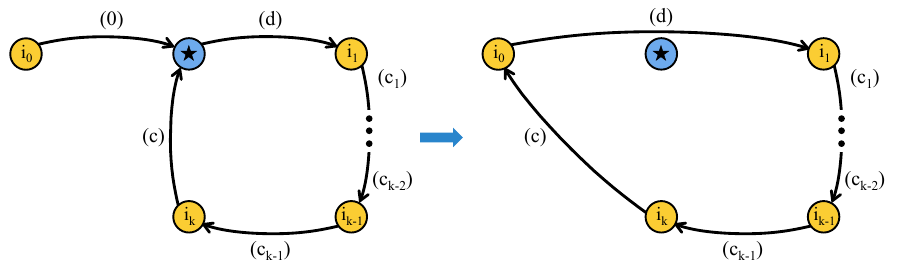
Figure 20. Mutation of a superpotential term in the presence of an additional chiral (cid:12)eld going intothe mutated